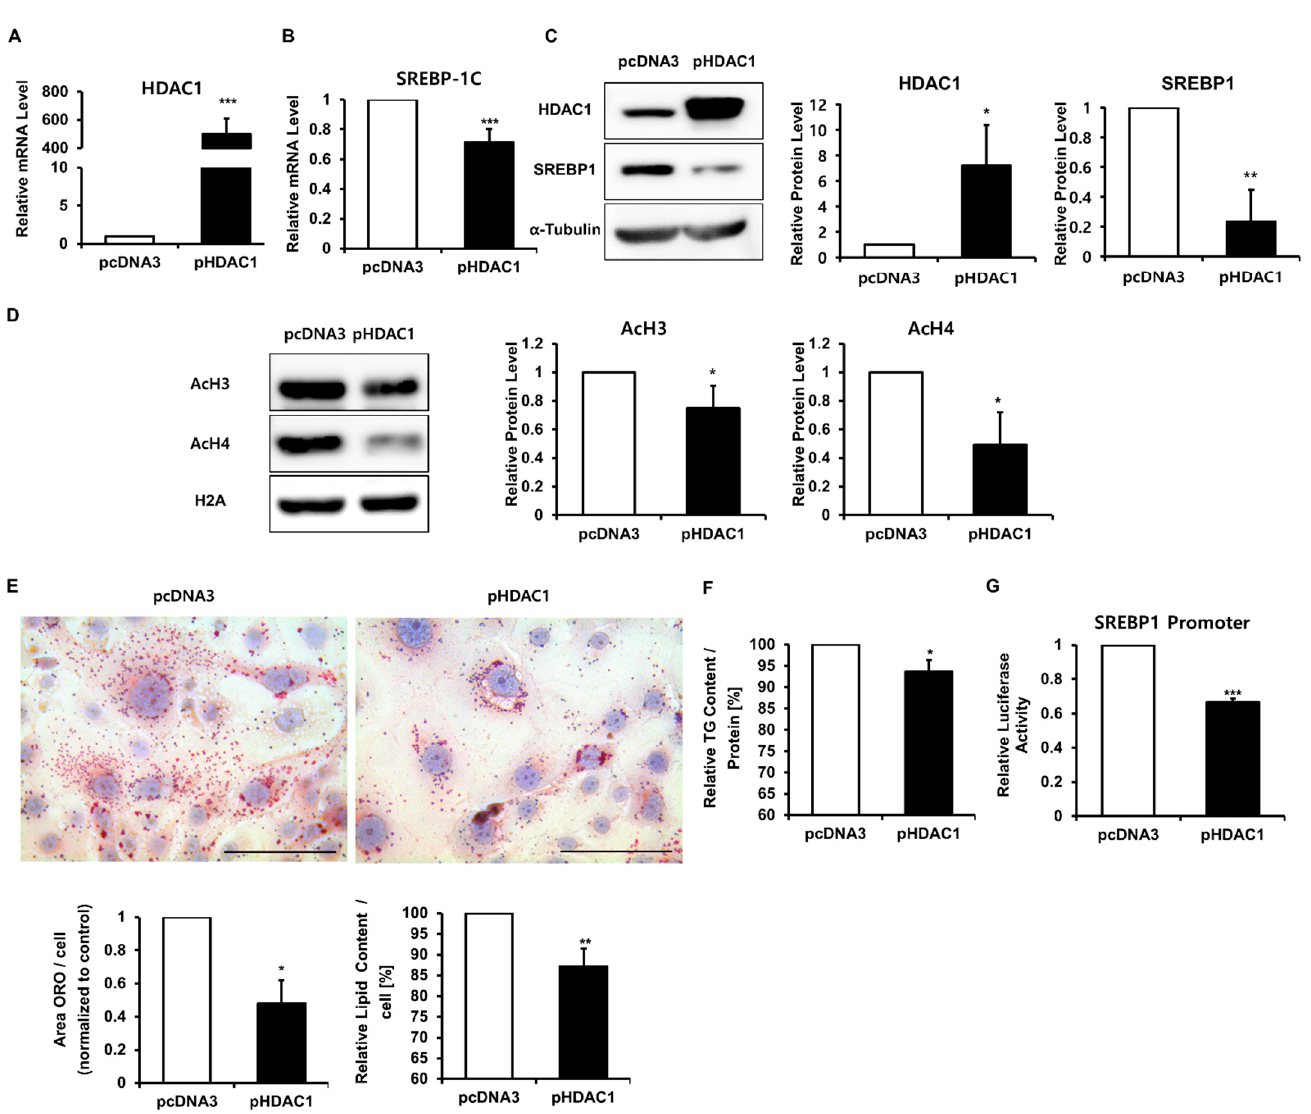
Figure 5. Histone deacetylase 1 (HDAC1) suppressed sterol regulatory element binding protein 1c (SREBP-1c) transcription and lipogenesis in SZ95. SZ95 cells were transfected with the pcDNA3 control vector or HDAC1 plasmid DNA for 6 h and the medium was replaced with medium containing 2% FBS, insulin, and the liver X receptor (LXR) agonist TO901317. Cells were harvested at 48 h for mRNA, protein, and histone protein analyses. ( A , B ) HDAC1 and SREBP-1c mRNA levels analyzed using real-time PCR. ( C ) HDAC1 and SREBP1 protein levels measured using Western blotting. α -Tubulin served as a loading control. ( D ) Histone H3 and H4 acetylation observed using Western blot analysis. Histone H2A served as a loading control. ( E ) Oil Red O staining was performed to analyze the amount of lipid droplets at 72 h. Scale bar = 100 µm. Quantitative analysis of Oil Red O was performed using the Image J software (left). The lipid content was eluted into isopropanol, and the optical density at 500 nm was determined using a microplate reader (right). ( F ) Triglyceride (TG) content analysis using a TG assay kit performed at 72 h. ( G ) SREBP1 promoter activity was measured using a luciferase assay 24 h after pcDNA3 or HDAC1 plasmid transfection. Data represent the mean ± SD of four independent experiments ( n = 3). * p < 0.05, ** p < 0.01, *** p < 0.001 vs. pcDNA3-transfected control.